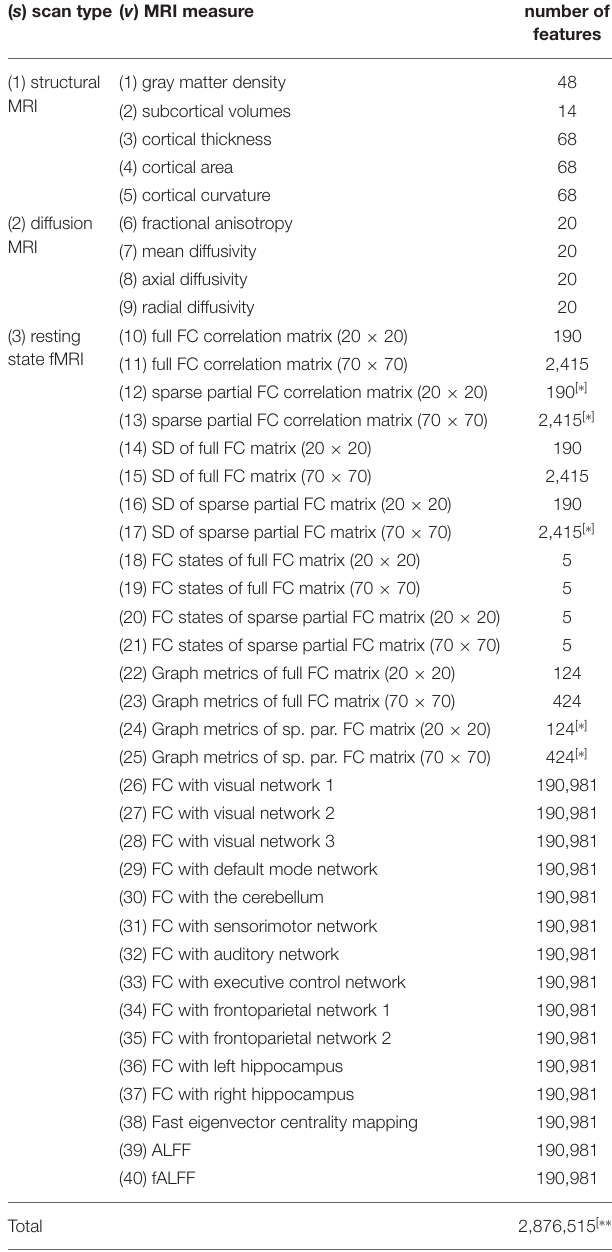
TABLE 1 | Overview of the scan types, MRI measures, and corresponding number of features used in this